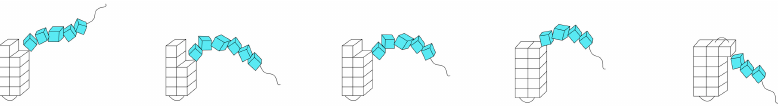
Figure 4. Schematic diagrams of the “fine grained model” proposed by Frank and Tosi. A series of sub-steps would take place in order to form a single stem; however, fluctuation on and off by subunits can only occur along the vertical direction, and folding is inaccessible before it reaches the lamellar thickness.